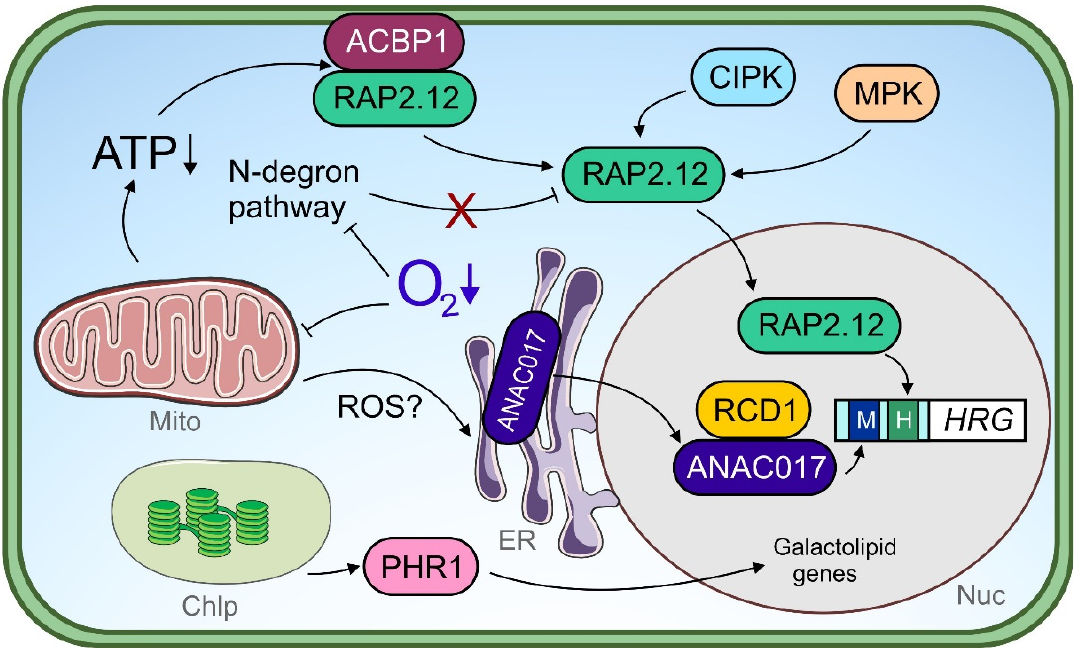
Figure 2. Transcriptional regulators under hypoxia. Under O 2 limitation, the mitochondrial function is impaired leading to lower ATP production. An energy crisis induces dissociation of the ACBP1-RAP2.12 complex at the plasma membrane. Released RAP2.12 translocates to the nucleus and free RAP2.12 protein is stabilized upon a dysfunctional N-degron pathway, which uses O 2 as a co-substrate. The post-translational modification of RAP2.12 by mitogen-activated protein kinases (MPKs) and calcineurin-b-like interacting kinases (CIPKs) may regulate transcription factor (TF) function. In the nucleus, RAP2.12 activates hypoxia-responsive genes (HRG) and binds to the hypoxia-responsive promoter element (HRPE, shown as “H”) within target promoters. Endoplasmic reticulum-(ER-)localized ANAC017 is mobilized upon a mitochondrial dysfunction signal under hypoxia, potentially by reactive oxygen species (ROS). Nuclear ANAC017 is regulated in its function via physical interaction with radical-induced cell death 1 (RCD1) and binds to target gene promoters harboring the mitochondrial dysfunction motif (MDM, shown as “M”). Chloroplast signals under hypoxia are suggested to be transmitted to the nucleus by phosphate starvation response 1 (PHR1) and lead to the activation of galactolipid genes. Chlp, chloroplast; ER, endoplasmic reticulum; Mito, mitochondrion; Nuc,